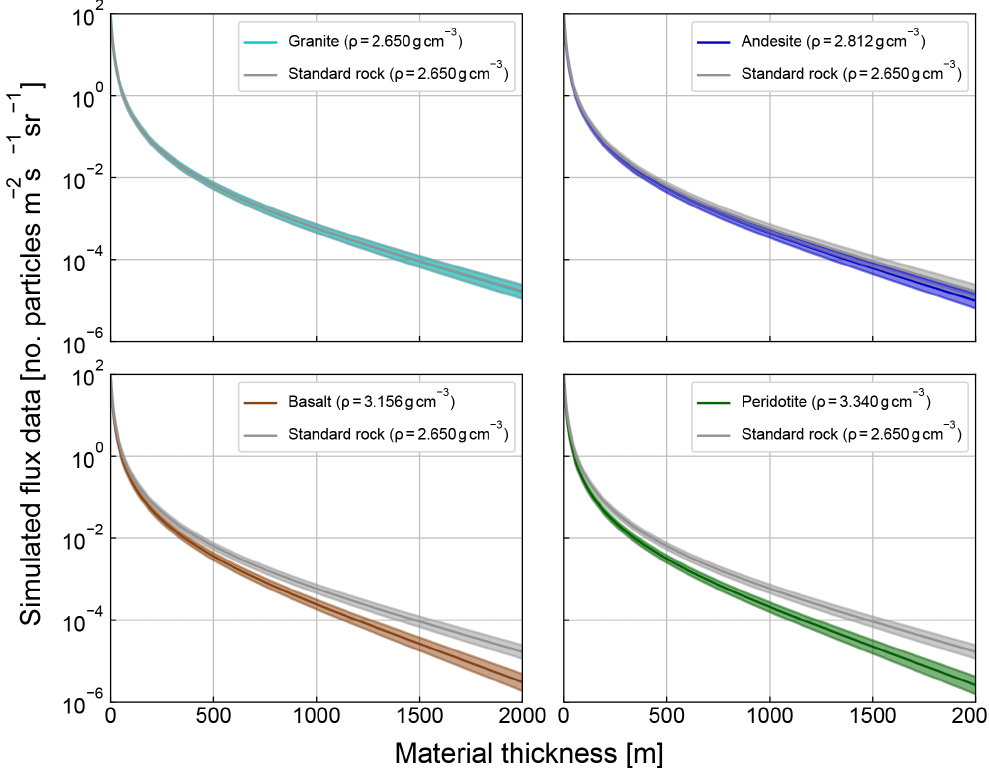
Figure 2. Simulated muon intensity vs. thickness of the four igneous rocks from Table 1 and standard rock. The mean flux is indicated by a bold line and 1 σ bounds are indicated by the shaded area.